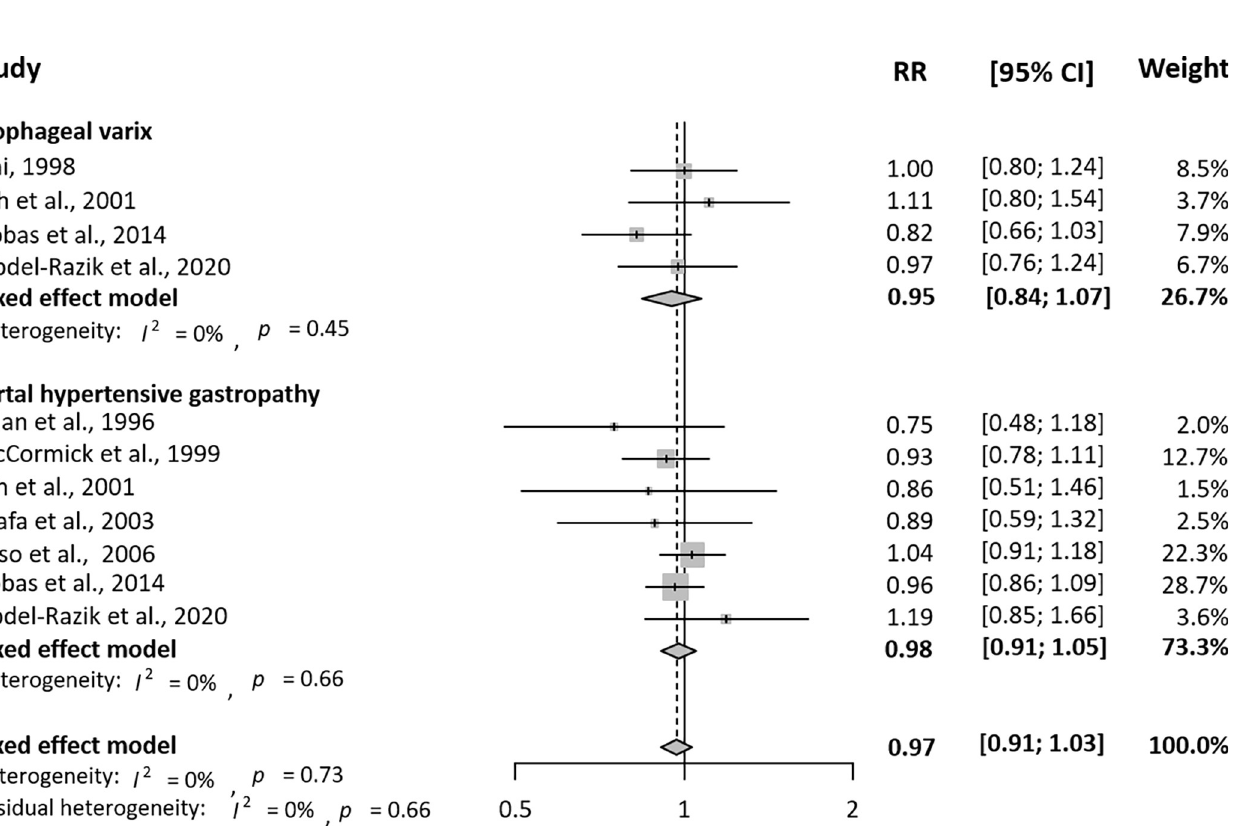
Fig 2. Unadjusted relative risk and 95% confidence interval of portal hypertension-related gastrointestinal complications by Helicobacter pylori infection in eight cohort studies. RR, relative risk; CI, confidence